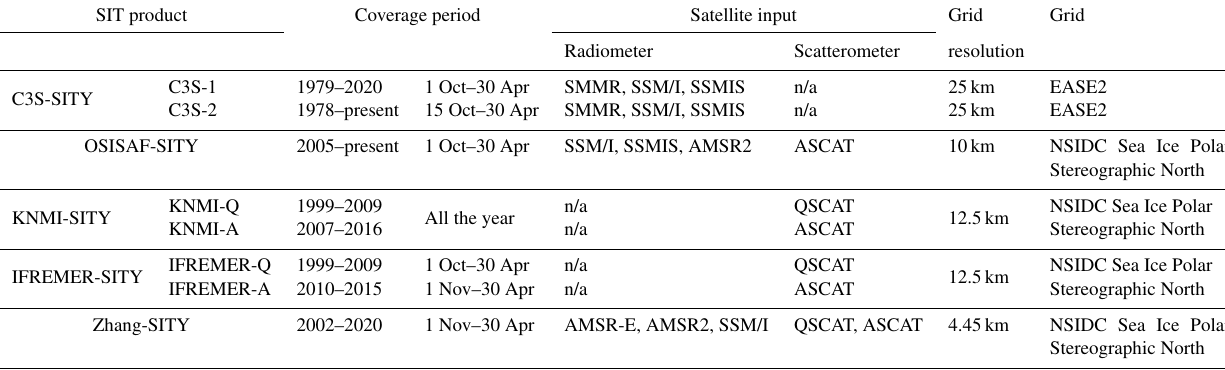
Table 1. Basic information of the SITY products. SIT product Coverage